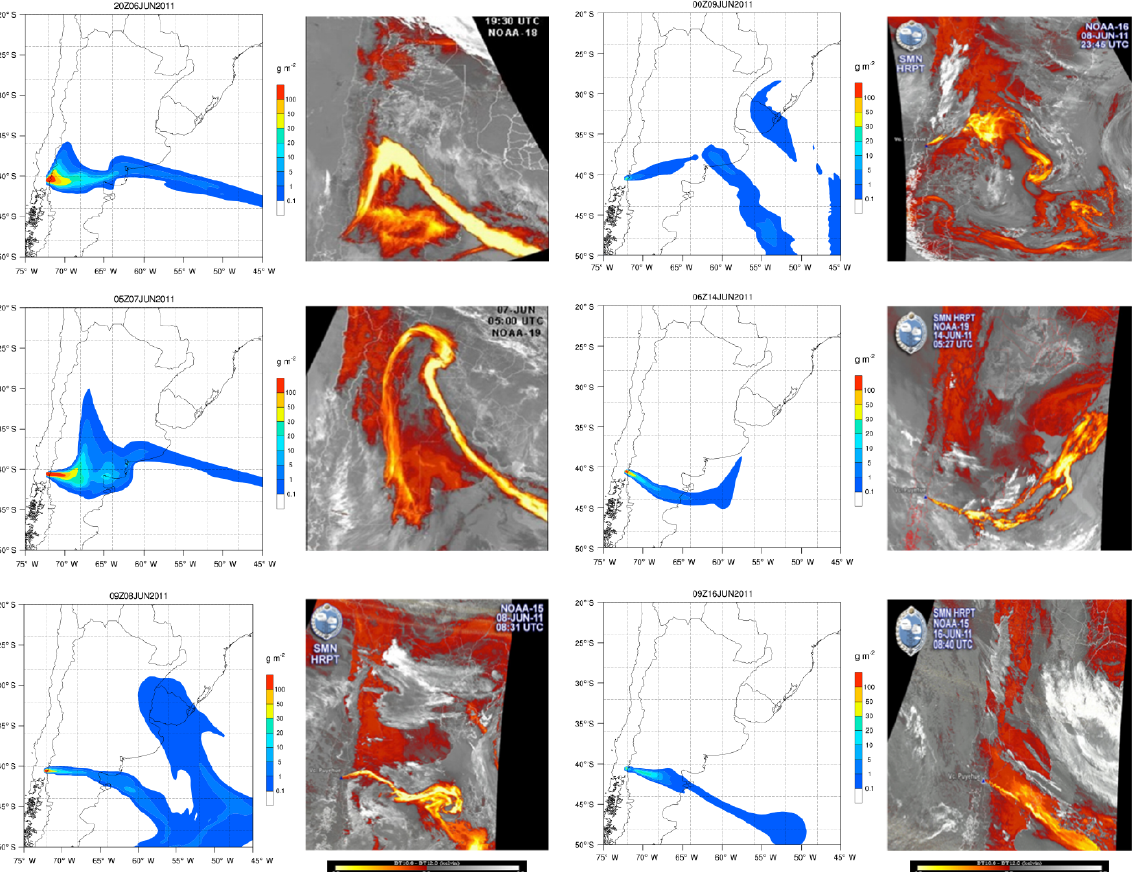
Figure 3. Composite image of NMMB-MONARCH-ASH results for dispersion of ash for the 2011 Caulle eruption at different time slices. Simulation results are compared against split window algorithm NOAA-AVHRR satellite images (bands 11–12 microns). Contours indicate ash column load (gm − 2 ) resulting from integrating the mass of the ash cloud along the atmospheric vertical